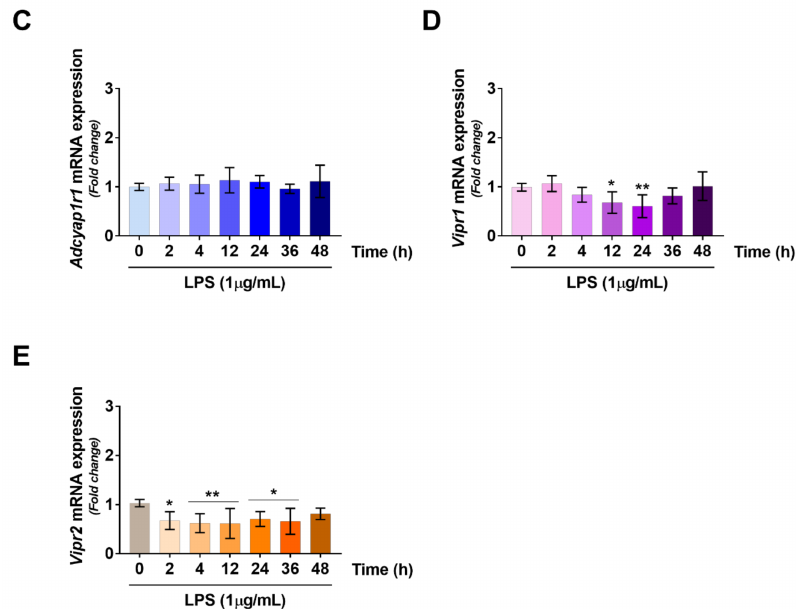
Figure 3. Time-course gene expression profiling of ( A ) Vip ; ( B ) Adcyap1 ; ( C ) Adcyap1r1 ; ( D ) Vipr1 and ( E ) Vipr2 mRNAs in RT4 SCs treated with LPS at the indicated concentration. Relative transcript levels were measured by quantitative real-time PCR analyses. Amplifications were performed using selected primers optimized for qPCR analyses (<150 bp length) recognizing fragments within the CDS of the gene of interest (for details refer to Table 1 below). Results are presented as mean fold changes of time 0 (control) ± SEM. Fold changes of each gene were obtained after normalization to the endogenous ribosomal protein S18 (reference gene) and then calculated using the comparative ∆∆ Ct method. Baseline expression levels of control were set to 1. Bar graphs depicted show the mean results obtained from two independent determinations using two separate batches of cells each time ( n = 4 ).